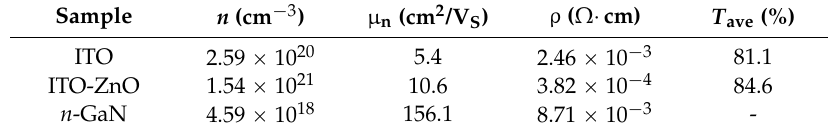
Table 1. Electrical properties and average optical transmittance of the ITO and cosputtered ITO-ZnO films as well as the electrical properties of the n -gallium nitride (GaN) epilayer.